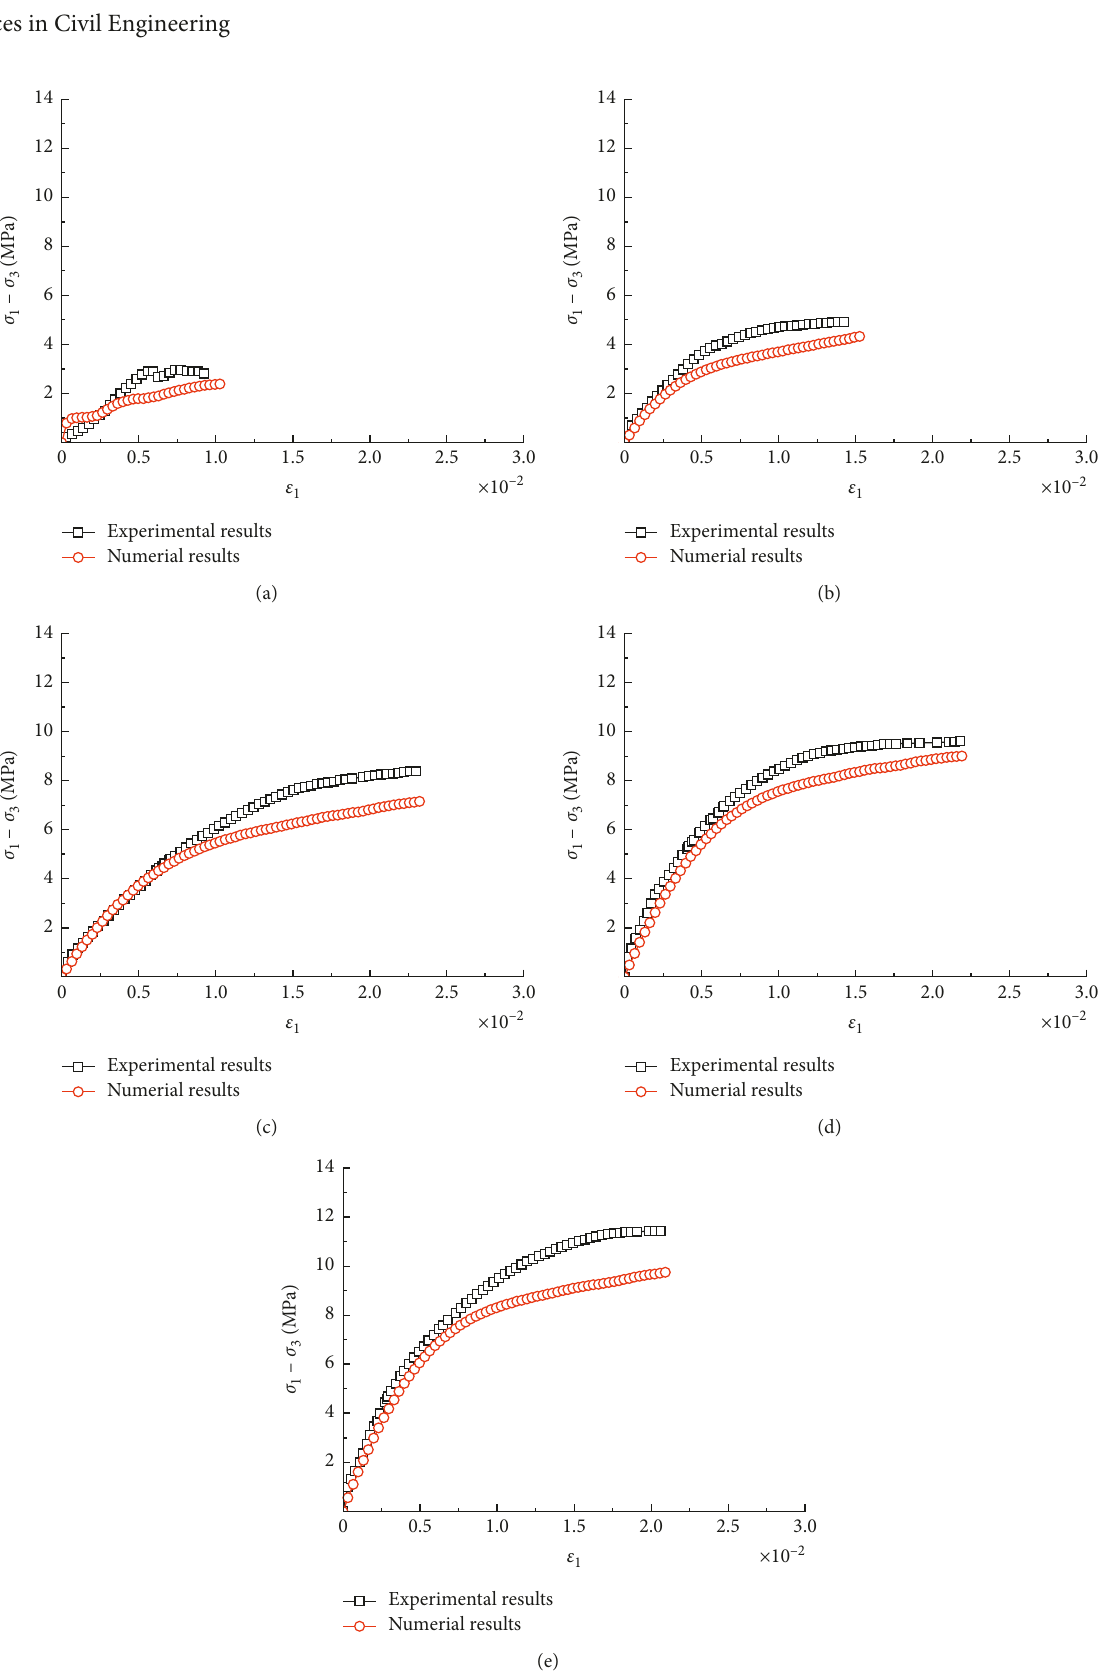
Figure 5: Numerical results and experimental results under different confining pressures: (a)